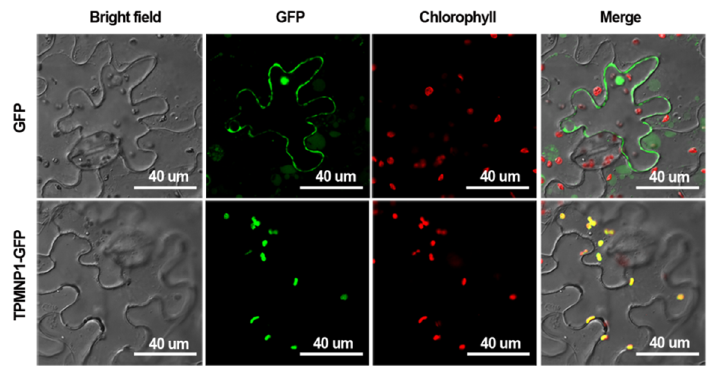
Figure 4. Subcellular localization of MNP1. According to ChloroP prediction, there is a chloroplast transit peptide (cTP) at the N -terminus of MNP1 protein, so a sequence encoding 100 amino acids containing cTP was used to generate p35S::TPMNP1-GFP constructs. Then, the constructs were transformed into tobacco ( Nicotiana benthamia ) leaf epidermal cells by Agrobacterium -mediated transformation. p35S::GFP was used as a positive control. Images were taken 36 h after transformation with dual GFP (green) and chlorophyll (red) channels. Scale bar = 40 um.